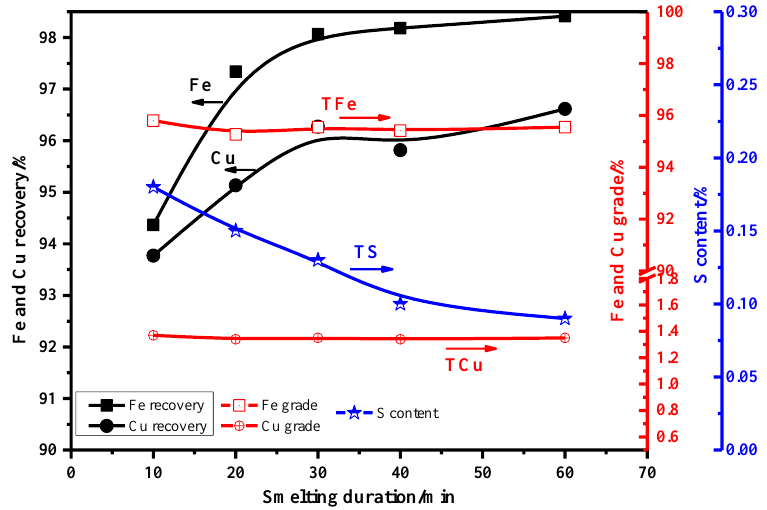
Figure 6. E ff ect of smelting time on Fe and Cu recovery and S removal (Smelting at 1550 ◦ C with Figure 6. Effect of smelting time on Fe and Cu recovery and S removal (Smelting at 1550 °C with 0.7 0.7 basicity).